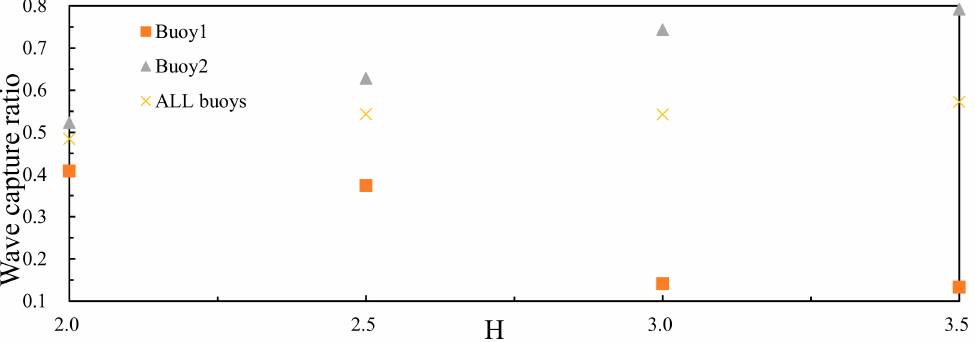
Figure 18. Curve of capture width ratio with